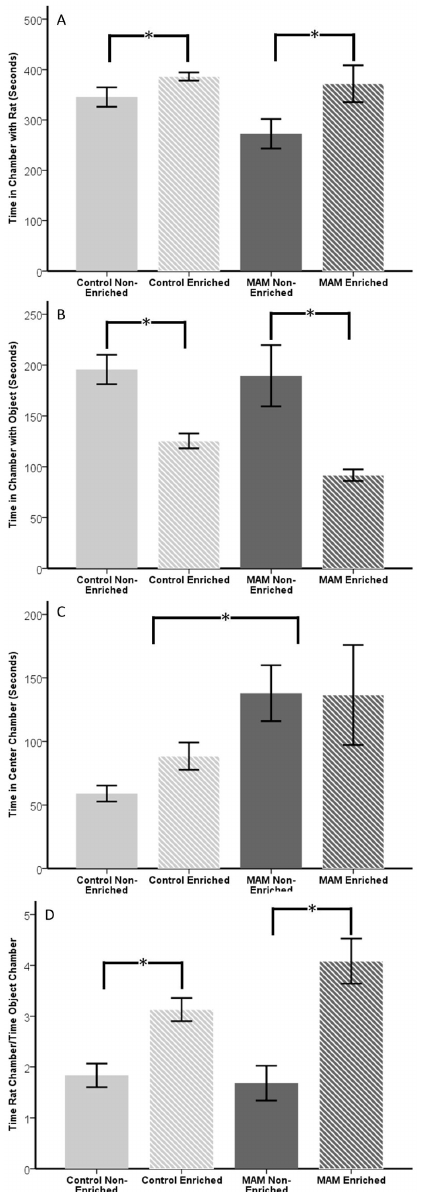
Figure 5. Data from the three chambered social choice test with control non-enriched, control enriched, MAM non-enriched and MAM enriched. ( A ) Control non-enriched (solid grey bar) and MAM non-enriched (solid black bar) spent less time with the novel rat than their enriched counterparts (striped bars) (p<0.006). ( B ) Non-enriched animals spent more time with the novel object than enriched animals (p<0.001). ( C ) While MAM did not significantly affect time spent in the chamber with the novel rat or novel object, there was a significant effect on time spent in the center chamber (p<0.001). ( D ) When the data was examined as a ratio of time spent with novel rat over time spent with novel object, the enrichment effect remained and the trend for a MAM effect was gone. Error bars represent standard error. doi: 10.1371/journal.pone.0084492.g005 PLOS ONE |